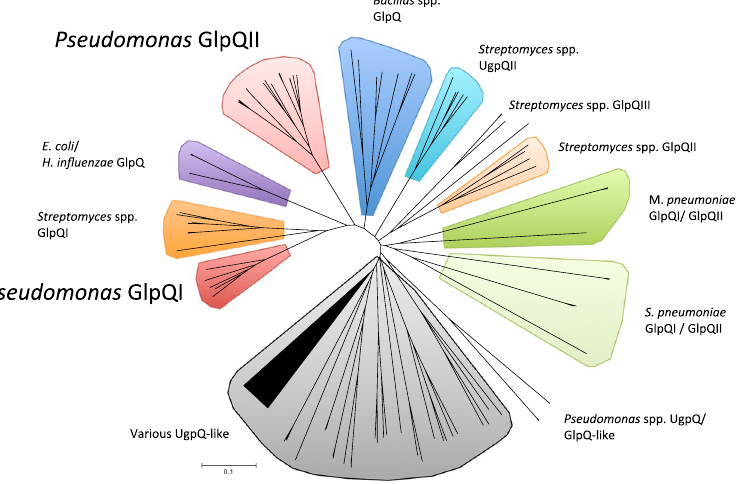
Figure 1. Phyologenetic analysis of GlpQI (DSM4166) and GlpQII (SBW25) in relation to other characterised and non-characterised proteins containing the Pfam domain – 03009. A full list of genomes used in the search is provided in Table S5. The evolutionary history was inferred using the Neighbor-Joining method 50 . The optimal tree with a sum of branch length = 17.19752950 is shown. The tree is drawn to scale, with branch lengths in the same units as those of the evolutionary distances used to infer the phylogenetic tree. The evolutionary distances were computed using the p-distance method and are in the units of the number of amino acid differences per site. The analysis involved 144 amino acid sequences. All ambiguous positions were removed for each sequence pair. There were a total of 483 positions in the final dataset. Evolutionary analyses were conducted in MEGA6 51 . Bootstrap values were omitted for clarity.